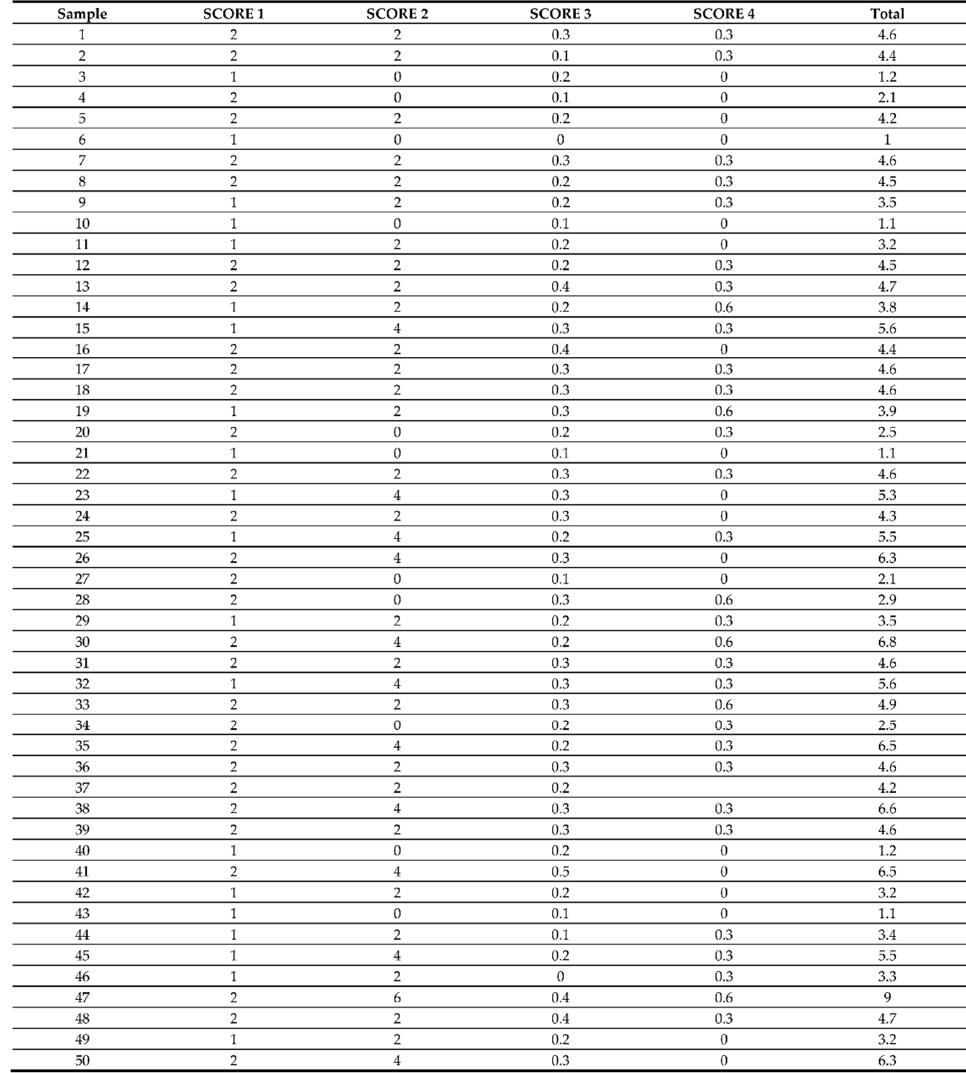
Figure A1. Space Time Scan Statistics results summary (first 50 samples).